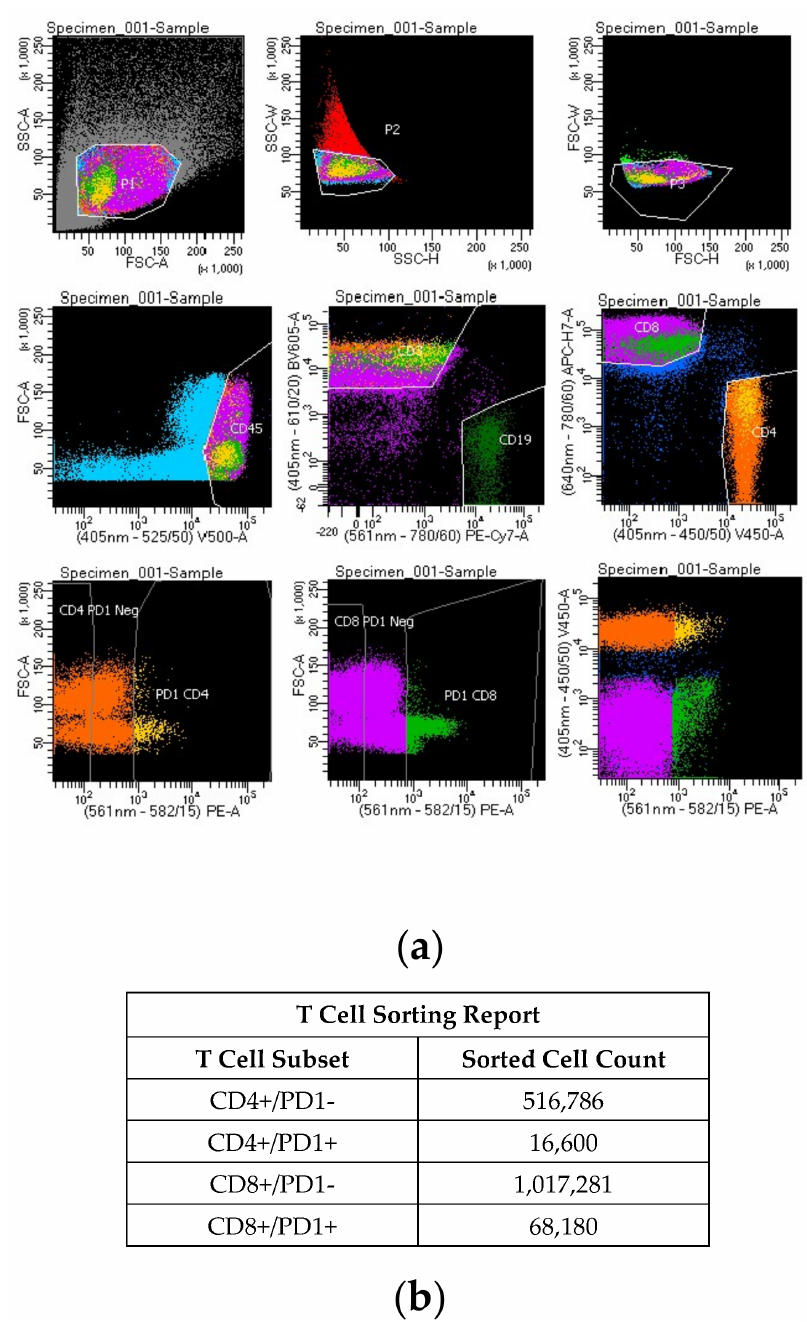
Figure 4. Legend: ( a ) Fluorescence-activated cell sorting (FACS); ( b ) cell sorter (CS) report. 3.4. T-Cell Receptor Clonality Analysis by Next-Generation Sequencing (NGS) T-cell receptor (TCR) gene rearrangement studies for TCR gamma (TRG) and TCR beta (TRB) chains by NGS demonstrated the same clonal TCR gene rearrangements in CD8+ (PD1- or PD1+) sorted cell populations (Figure 5), which was the same as what was detected in the unfractionated cell extracts from the present as well as all prior skin biopsies that were performed at our institution. In contrast, a polyclonal pattern of TCR gene rearrangement was obtained in CD4+ (PD1- or PD1+)